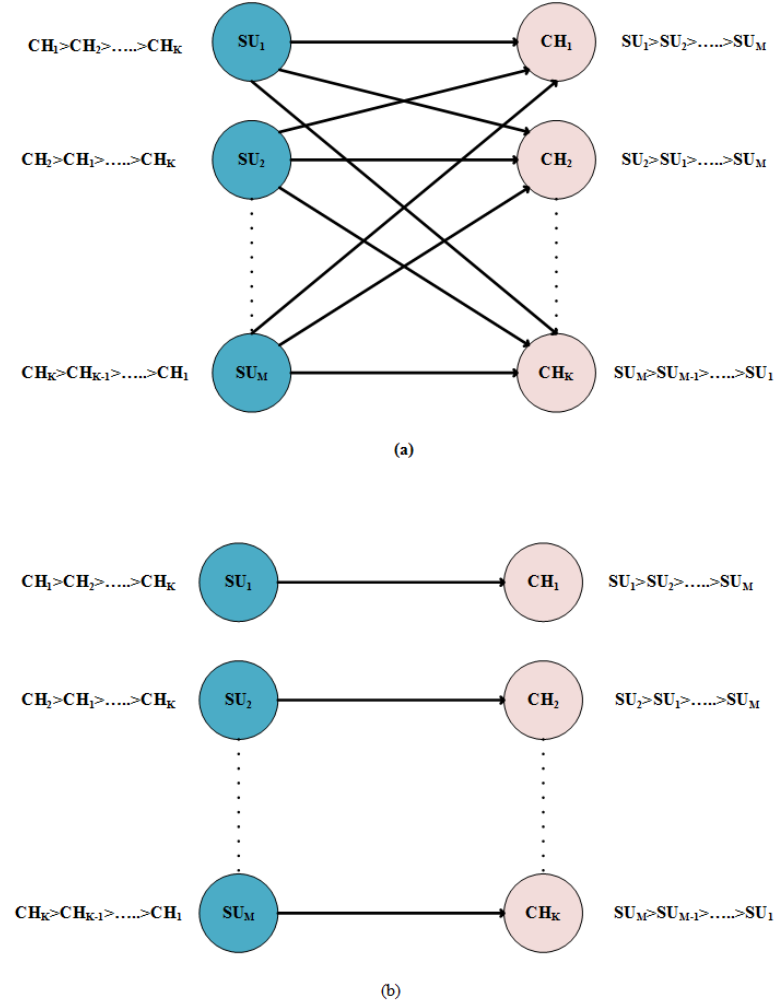
Figure 3. SPDA Channel allocation: ( a ) before allocation, ( b ) after